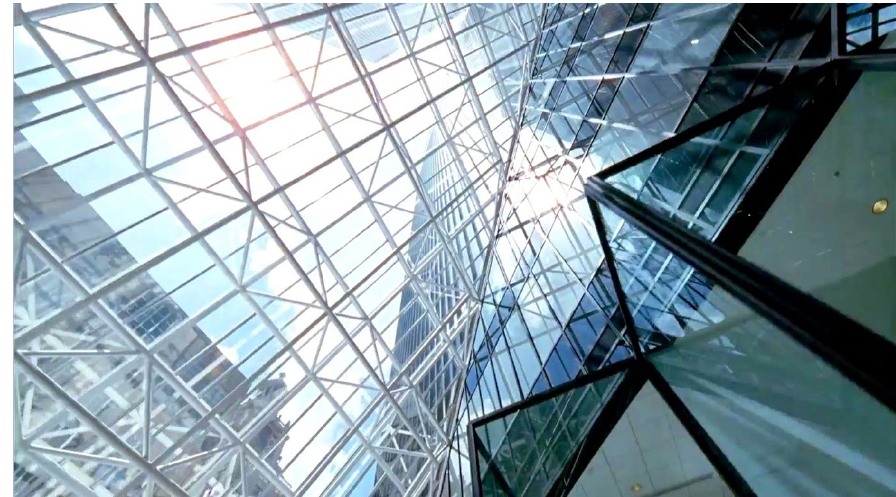
Figure 16 The steel and glass-made building where Jack works looks like trees and branches or a forest in The Tree of